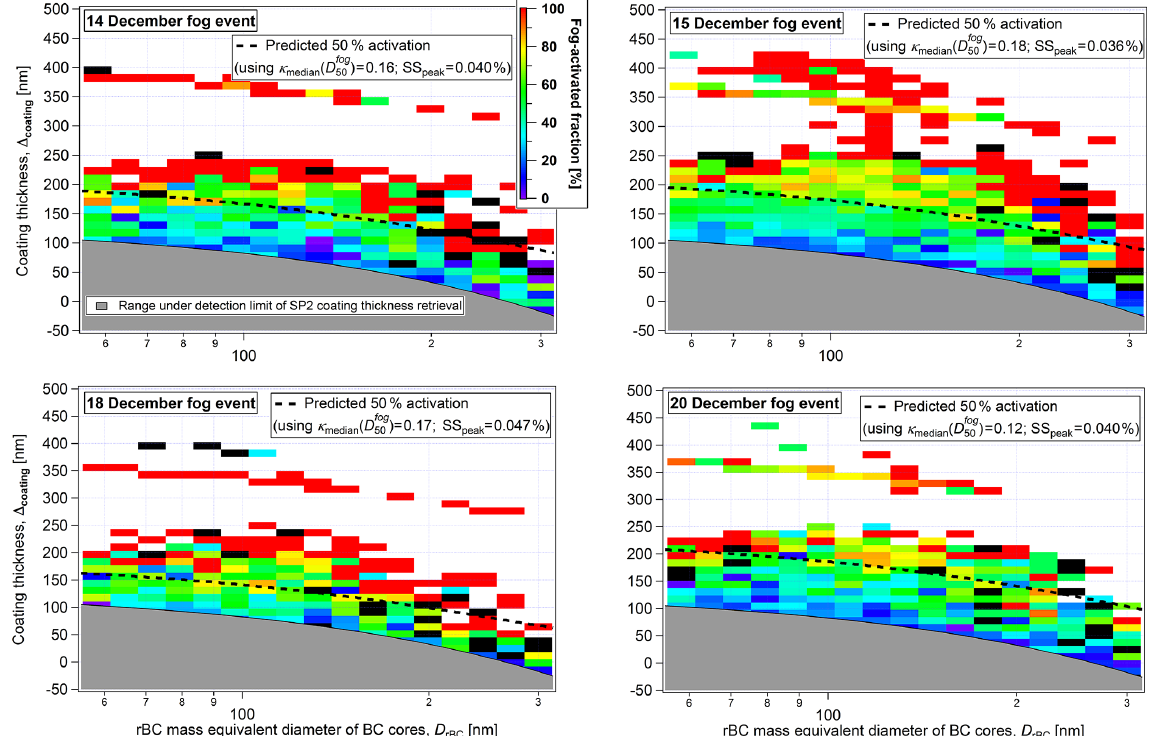
Figure 10. Fog-activated fraction of BC cores (colour scale for the four panels), i.e. number fraction of BC particles that formed a fog droplet according to the measurements behind the interstitial and total inlets, as a function of BC core mass equivalent diameter ( D rBC ) and coating thickness ( (cid:49) coating ), separately shown for all four fog events. The dashed line shows the pairs of core size and coating thickness for which the fog-activated fraction is expected to be 50% according to predictions based on the ZSR rule and κ -Köhler theory. Black pixels in the image indicate 2-D bins for which no particle was found in the total inlet data while at least one particle appeared in the interstitial inlet data, thus leading to a negative fog-activated fraction. The grey shadings mask the range that is below the detection limit of the SP2, i.e. D opt below around 210nm. The distinct band of data points at (cid:49) coating > ∼ 300nm appears for the same reason as the band at SS crit = 0 . 015% in Fig. 9a; see corresponding caption for